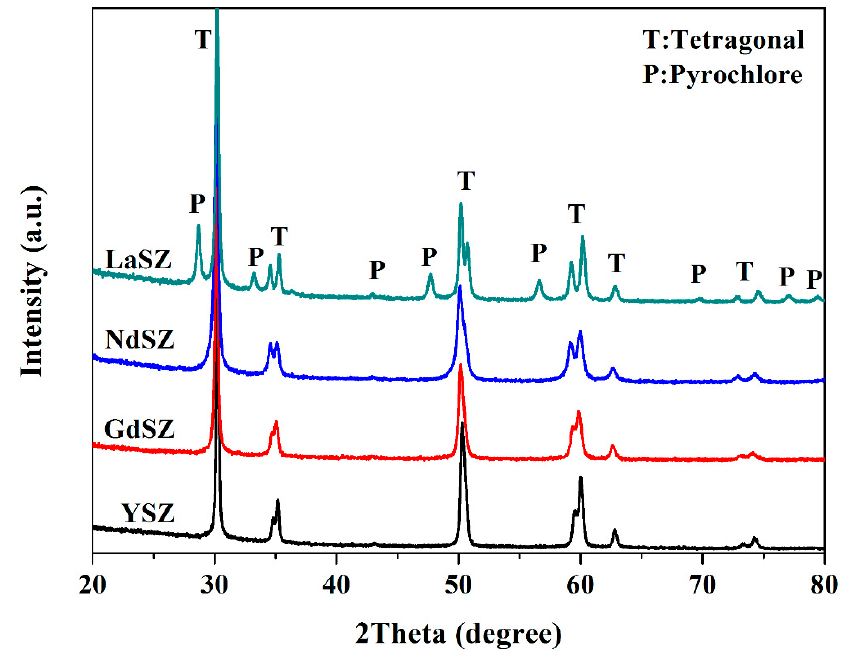
Figure 2. X-ray diffraction (XRD) patterns of LnSZ powders subjected to calcination at 1100 ◦ C for 6 h. SZ, YSZ, yttria-stabilized zirconia.